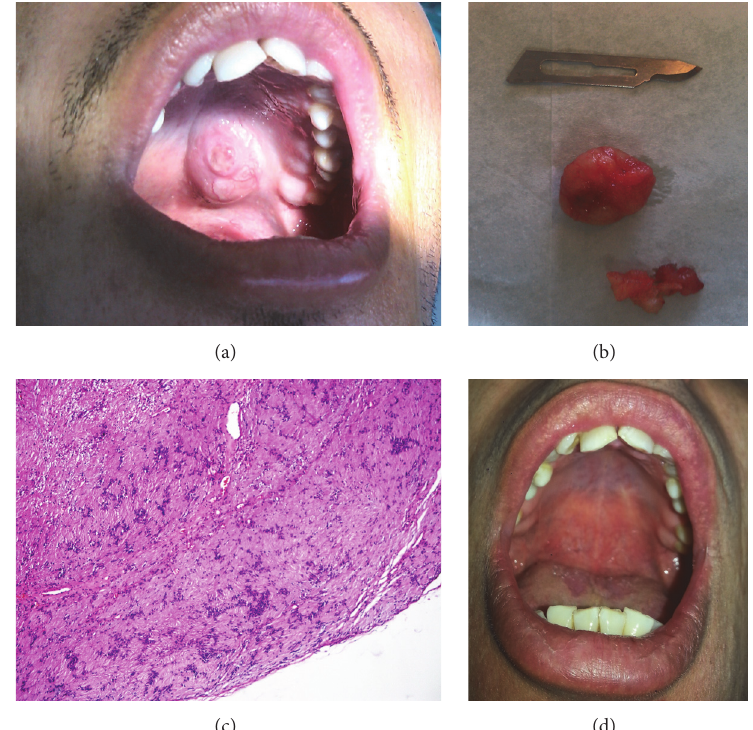
Figure 1: Images of the first case: (a) preoperative image of the oral cavity, (b) enucleated material, (c) schwannoma with massive cellular and fibrotic stroma (40x magnification), and (d) image of the oral cavity at the postoperative 18th